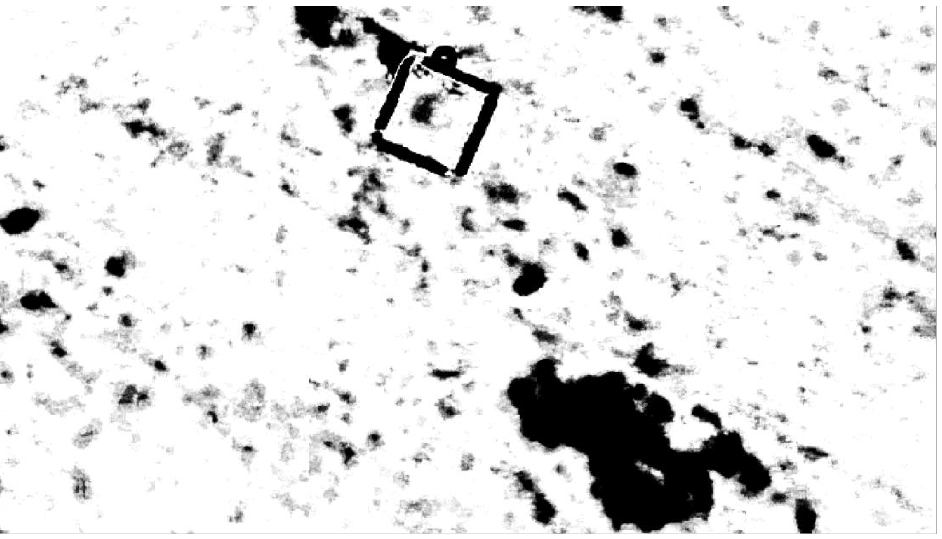
Figure 5. Orthomosaics and weed colour index threshold attempts; 1 m × 1 m grid in the upper middle. Darker areas are assumed to be weeds (image width approximately 10 m).